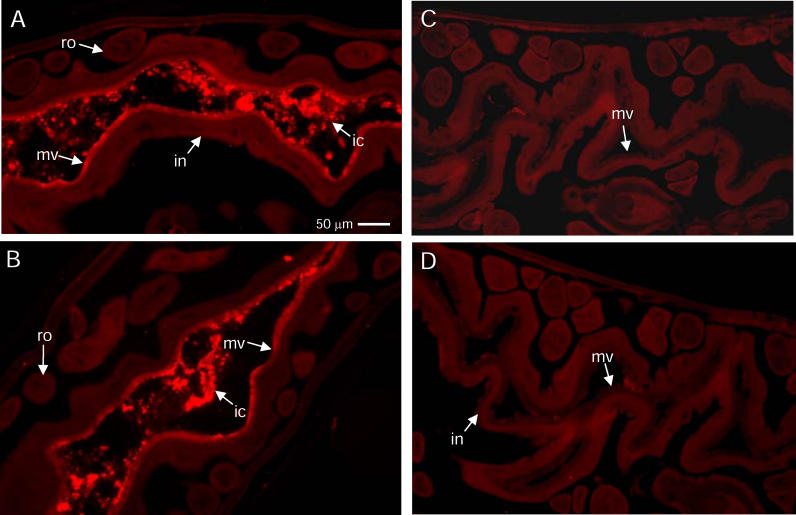
Antibodies Bind In Situ to the Intestines of Hookworms that Feed on Vaccinated DogsDetection of antibodies that bound to the gut of worms recovered from vaccinated dogs (A and B) but not control dogs (C and D) by immunofluorescence. Binding was detected using Cy3-conjugated rabbit anti-dog IgG, allowing only detection of antibodies that had bound in situ while parasites were feeding on blood from vaccinated or control dogs. ic. intestinal contents; in, hookworm intestine; mv, intestinal microvillar surface; ro, reproductive organs.